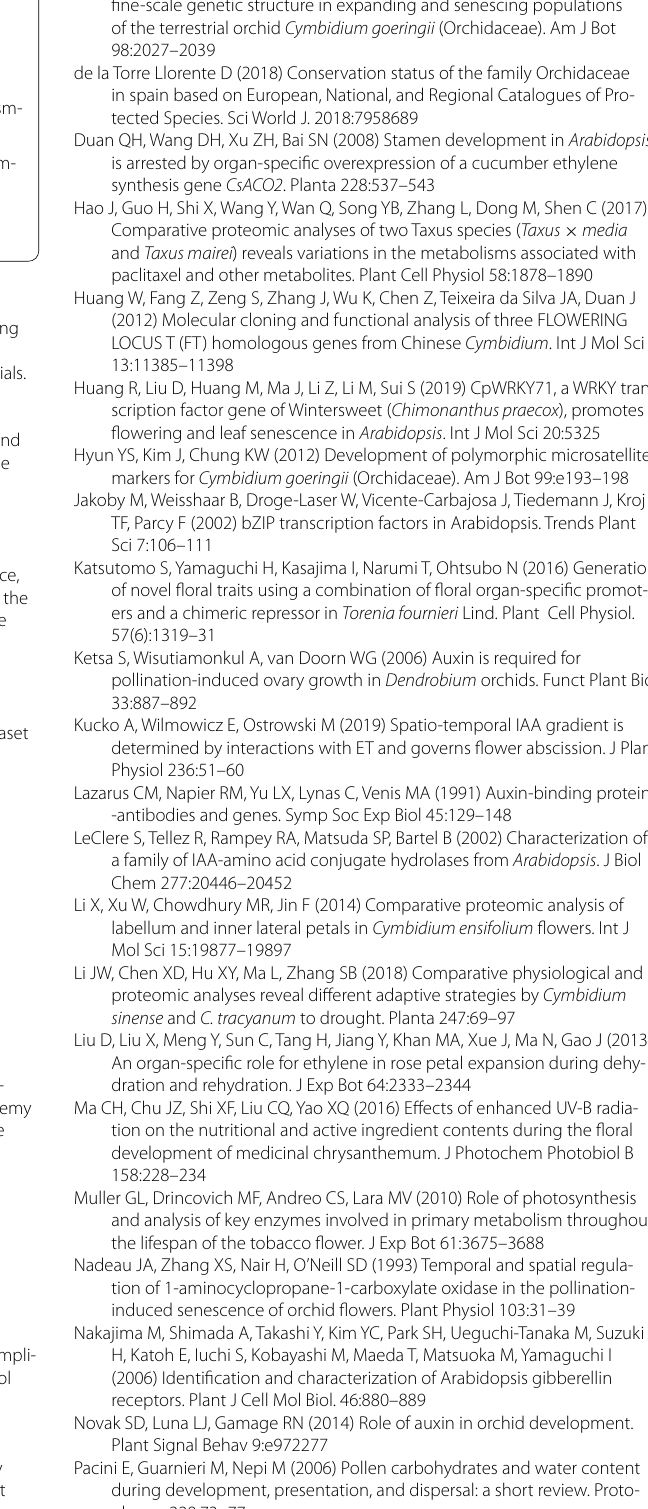
Additional file 1: Table S1. The basic information of all identified proteins. Additional file 2: Table S2. The basic information of amino acid metabolism-related proteins. Additional file 3: Table S3. The basic information of fatty acid metablism- related proteins. Additional file 4: Table S4. The basic information of energy metabolism- related proteins. Additional file 5: Table S5. The basic information of cell division and pigment related